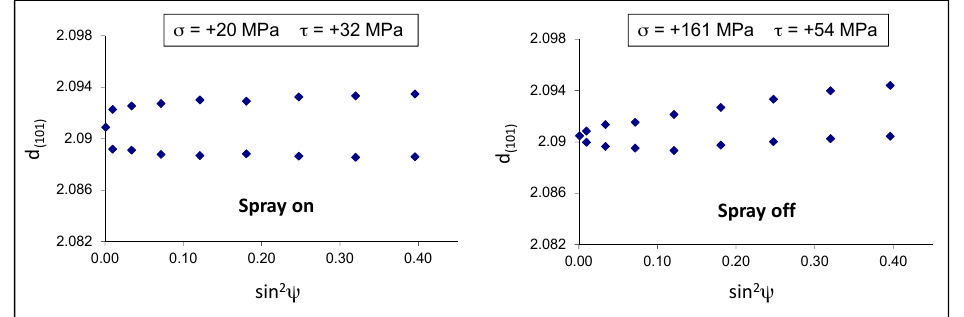
Figure 10. d-sin 2 ψ diagrams of steel 9A (spray on) and 9B (spray off) samples.